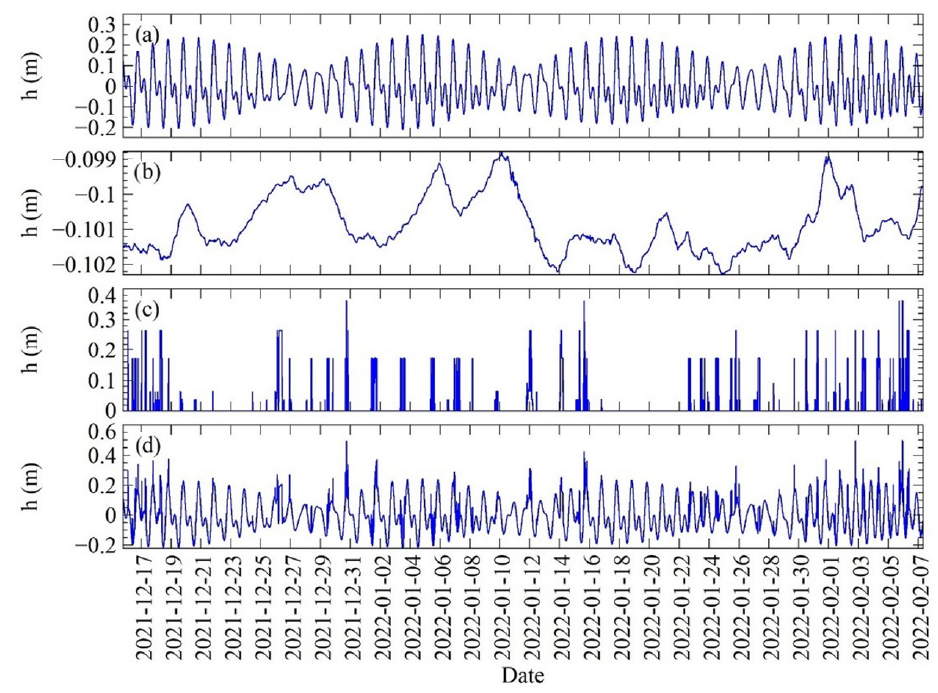
Figure 15. Calculated sea level height during the period from 15 December 2021–7 February 2022 caused by: ( a ) tidal effect, ( b ) barometric pressure-induced sea level changes, ( c ) wind-generated wave height and ( d ) absolute sea level